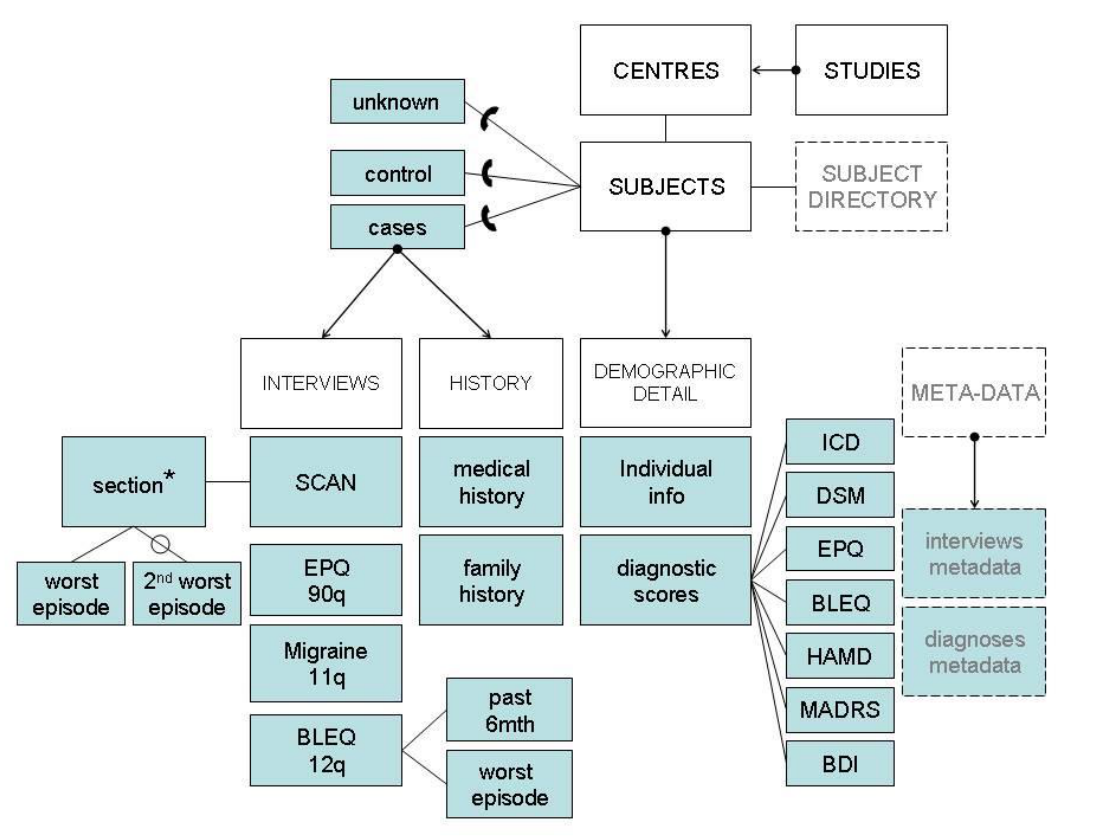
Figure 2: Boxes with solid border represent major entities or key attributes. Lines represent links between entities: optional link with a circle on the line, line with an arc means exclusive-or. Boxes with dash-line border are added concepts for the integrative phenotype